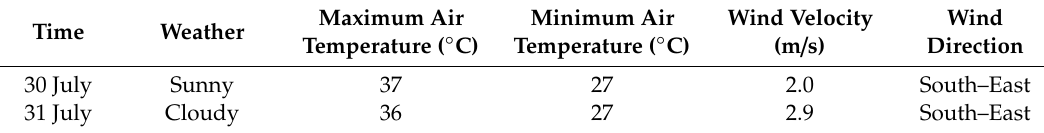
Table 2. Characteristics of the selected points [18].